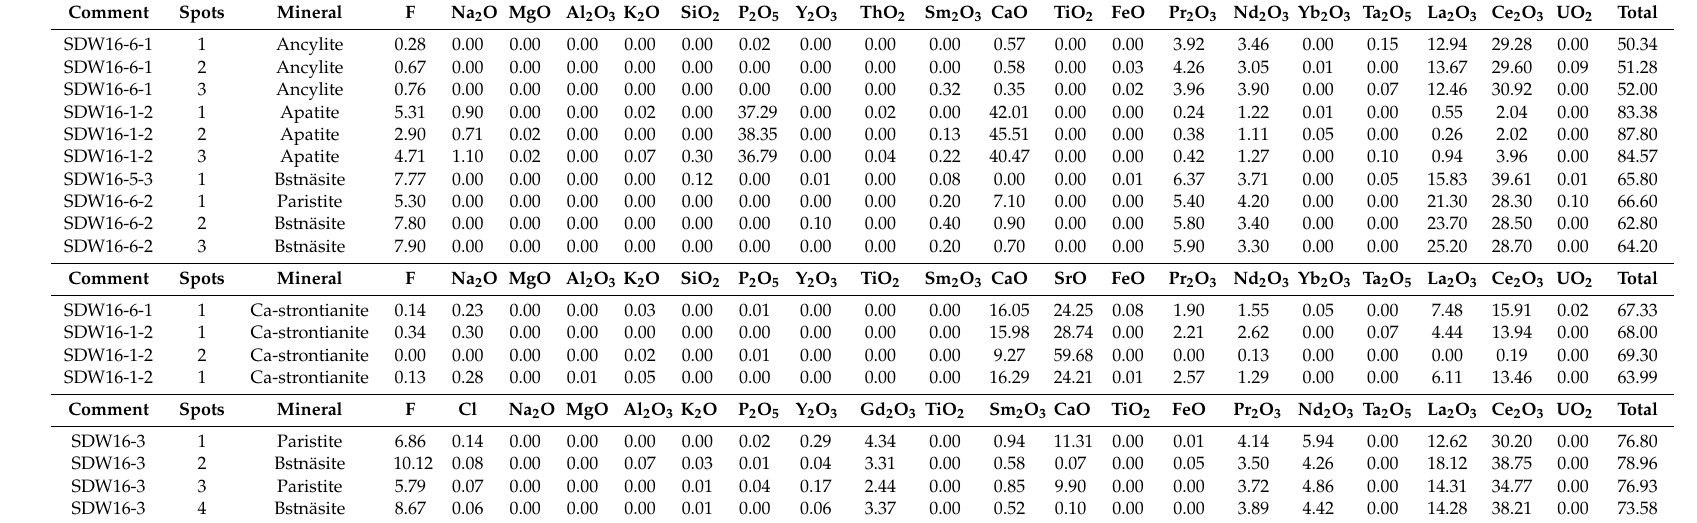
Table 4. Compositions of representative REE-bearing minerals formed during the hydrothermal stage in the Weishan REE deposit. Comment